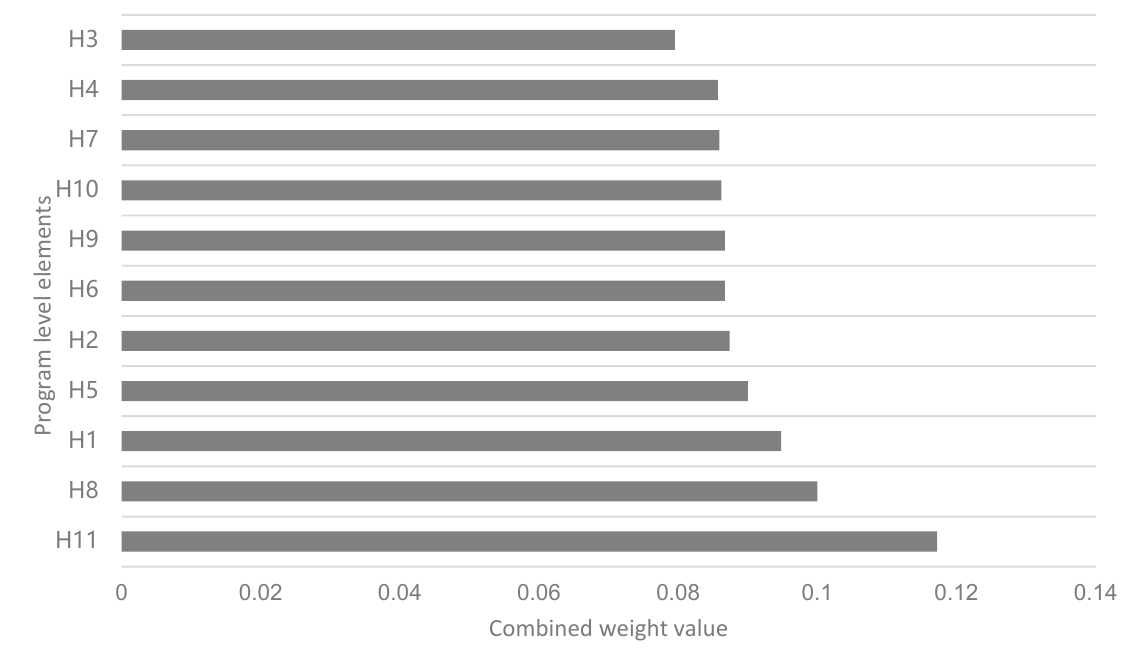
Figure 3. Statistical comprehensive weight values of scheme layer.